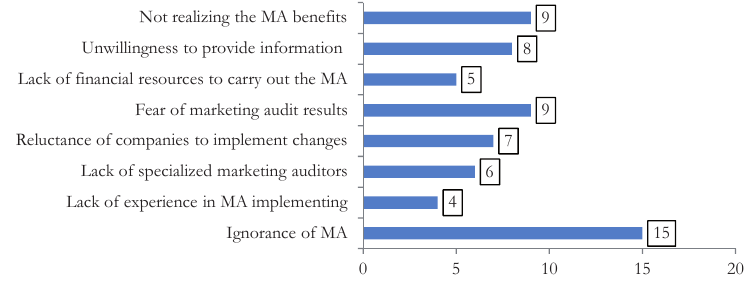
Fig. 2 – Barriers influencing the implementation of marketing audit in practice of companies (from an expert point of view). Source: Own